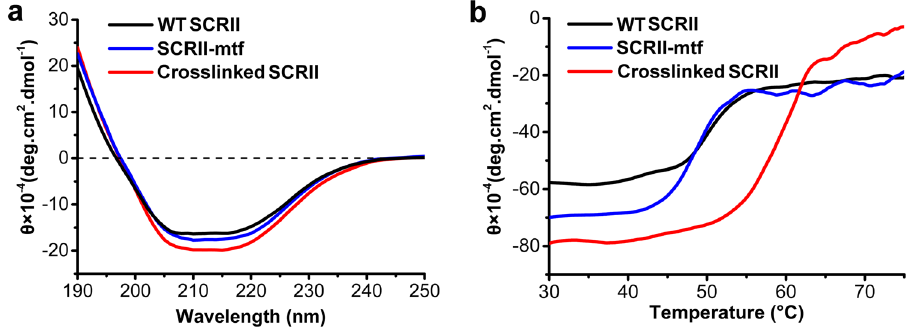
Figure 3. CD spectra ( a ) and thermal shift assays ( b ) of WT SCRII, SCRII-mtf and crosslinked SCRII. The CD spectra were recorded by measuring the ellipticity as a function of wavelength at 0.1-nm increment between 190 and 250 nm at 20 °C. Thermal shift assay was conducted by heating the three samples from 20 to 90 °C and then cooling to 20 °C by a Jasco programmable Peltier element with a rate of 1 °C/min. The wavelength of 209 nm that characterized the α -helix within protein was used to monitor the unfolding rate of the protein structures. The buffer (5 mM phosphate buffer pH 6.0, 0.1 mg/mL enzymes.) showed pH shift with no more than 0.5 while it was heated from 20 °C to 100